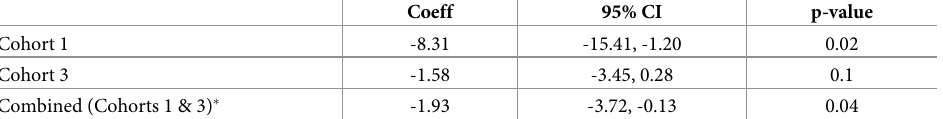
Table 5. Association between baseline leukocyte telomere length and number of acute exacerbations in the year prior to enrollment.